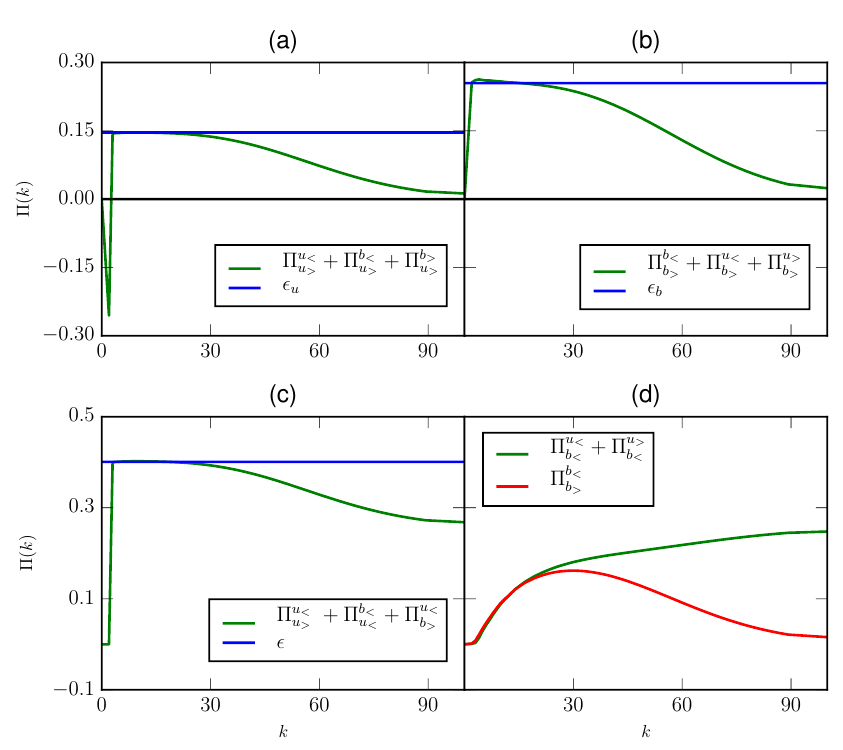
+ Π b > u + Π b < u (solid green > > > + + Π b < u > < + Π u > (solid green curve) b < b <